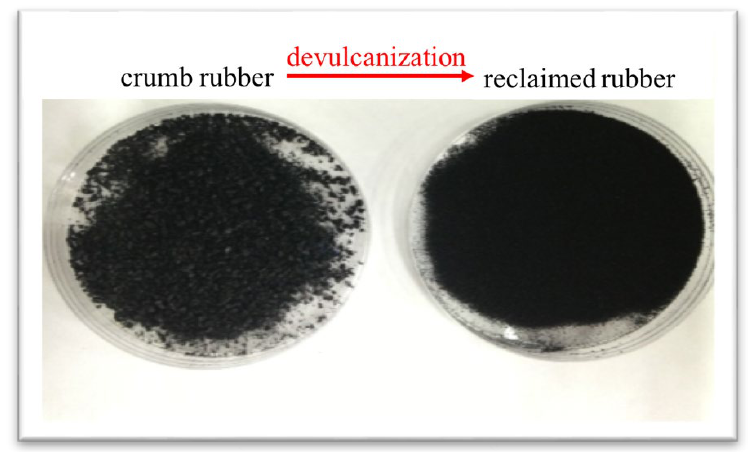
Figure 1. Optical image of as-received rubber sample provided from local market.